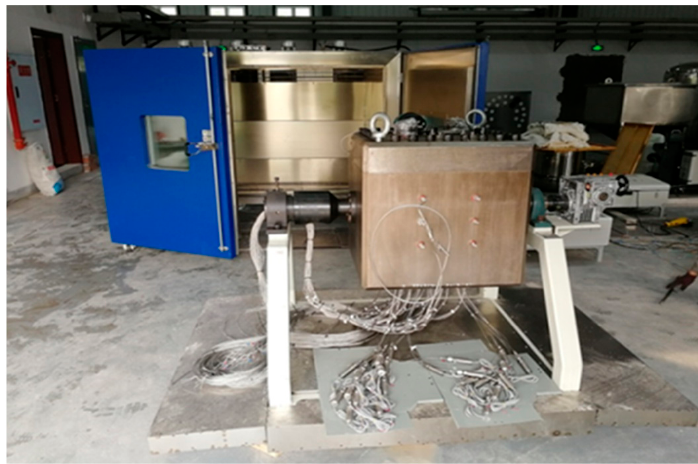
Figure 2. Three-dimensional physical model.